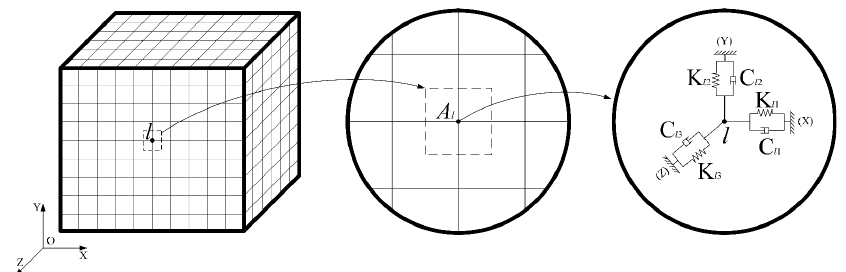
Figure 1. The 3D viscous-spring artificial boundary ( A l is the truncated boundary area of node l . K li , C li represents the springs and dampers at node l , respectively, where i = 1, 2, 3 for x, y, and z direction, respectively) (adapted with permission from ref. [37], Copyright 2016, John Wiley and Sons).